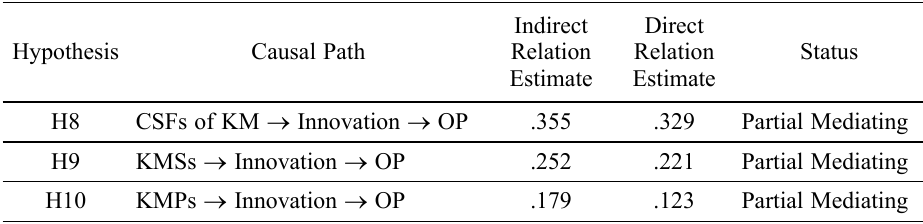
Table 3. Indirect relationships of final structural